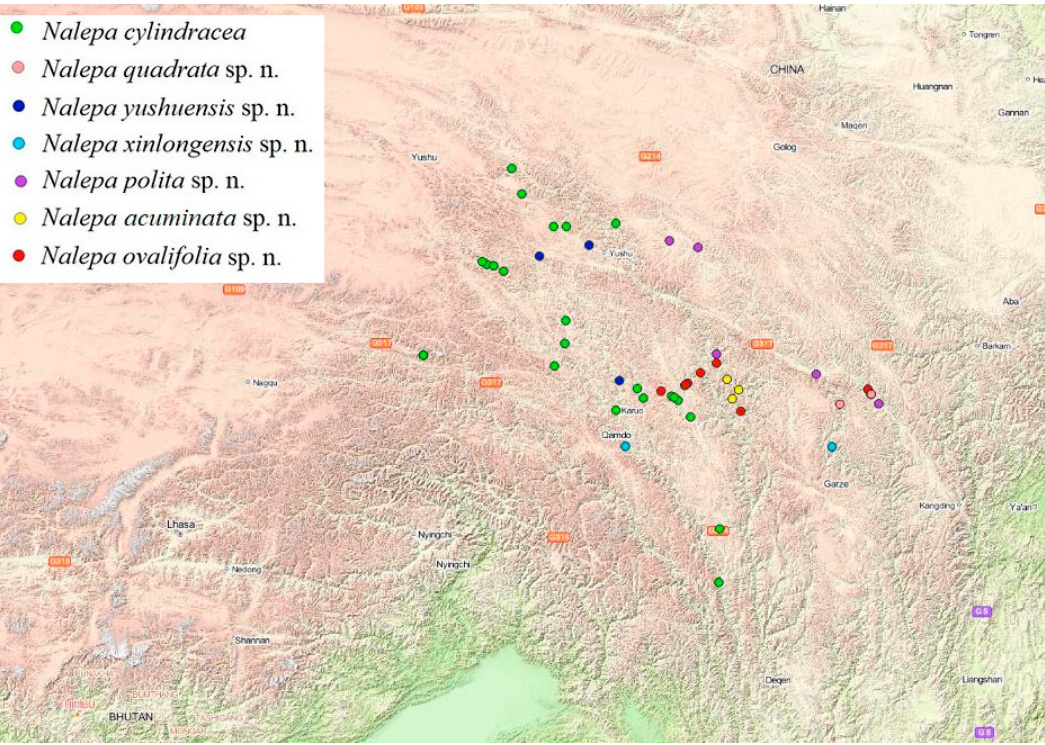
Figure 18. The geographical distribution of 49 samples of Nalepa used in this study. Each represents a separate species.